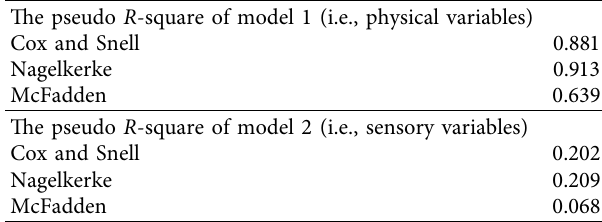
Table 5: Pseudo R -square.